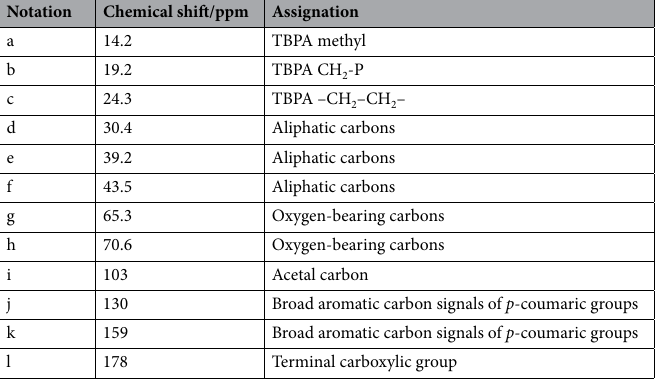
Table 5. Assignation of 13 C CP-MAS NMR spectra of sunflower (A) and rape (B) sporopollenins P2-purified by TBPH.